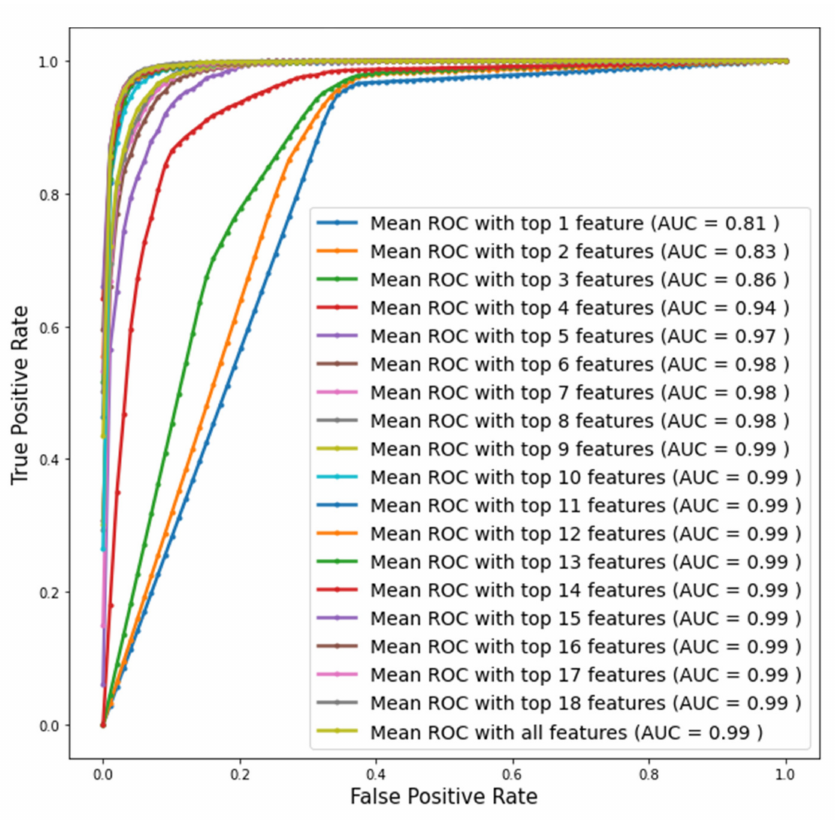
Figure 4. ROC curve of RF model with different features ranked by XGB.